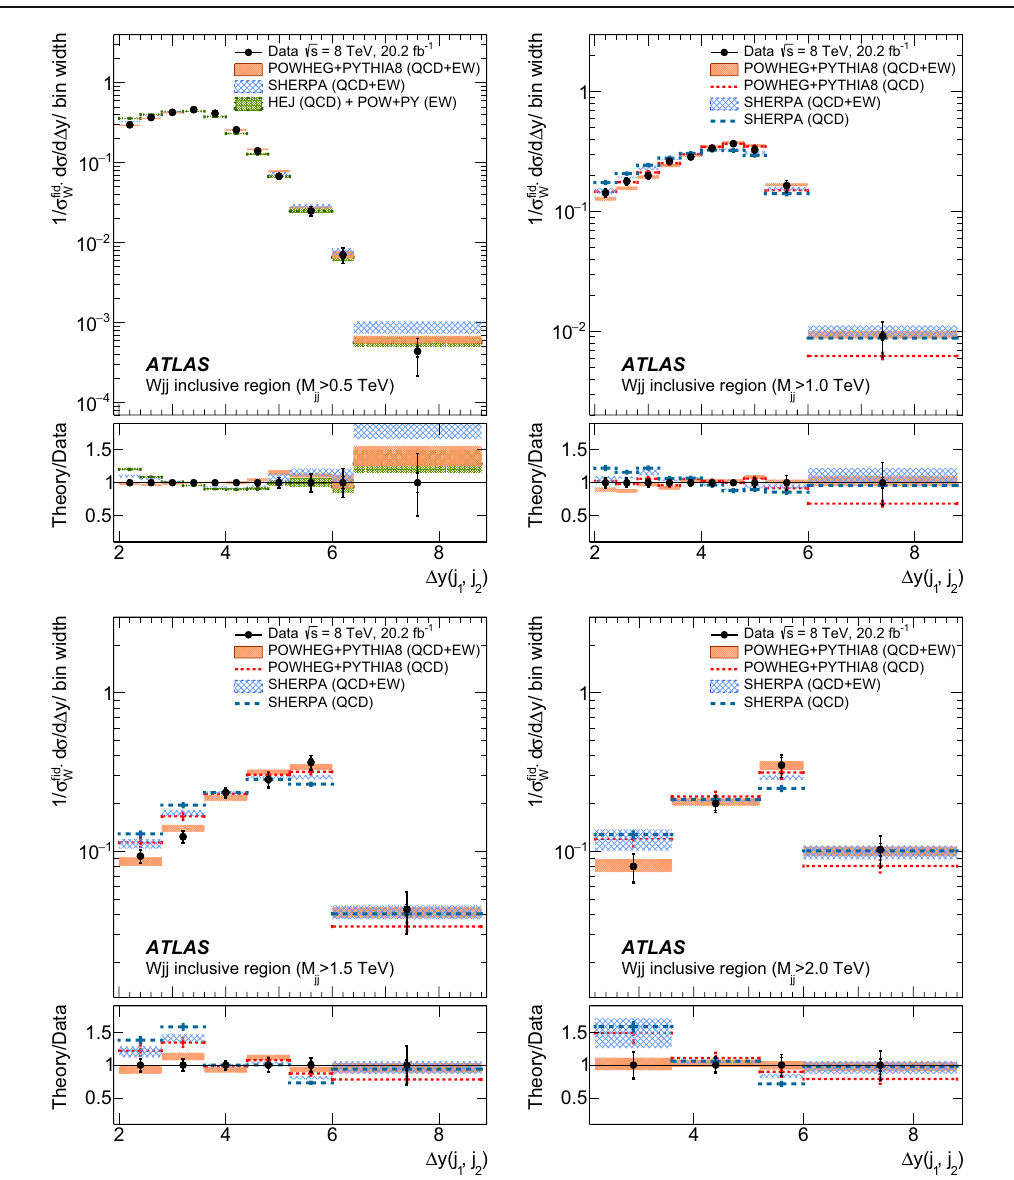
Fig. 31 Unfolded normalized differential W jj production cross sec- tions as a function of (cid:6) y ( j 1 , j 2 ) in the inclusive fiducial region with four thresholds on the dijet invariant mass (0.5, 1.0, 1.5, and 2.0 TeV).